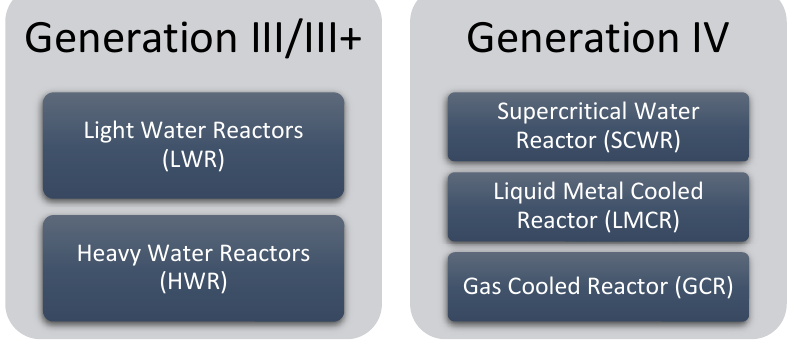
Figure 2. Classification scheme by technological generations.